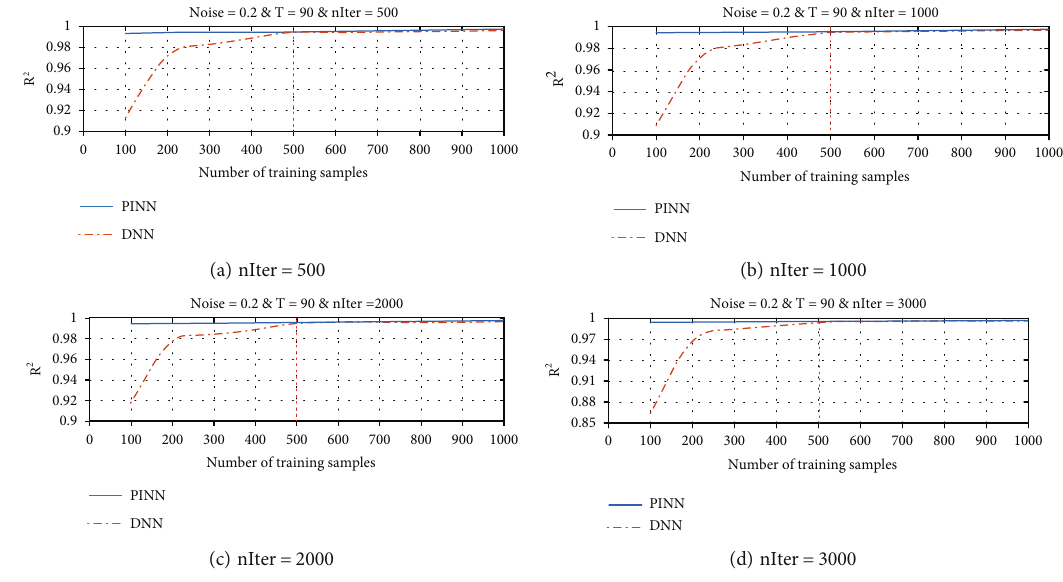
Figure 9: The e ff ect of sample